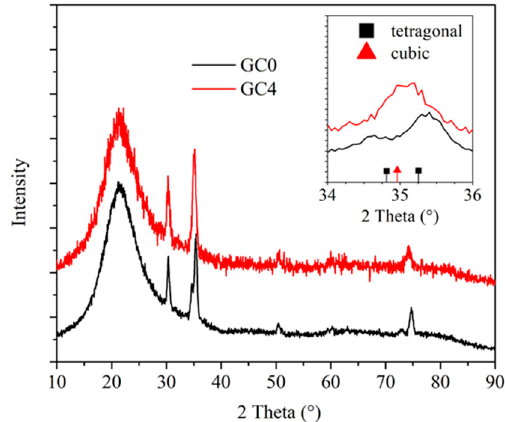
Figure 2. XRD comparison between undoped (GC0) and Yb-doped (GC4) silica-zirconia samples. The inset reports a selected region of the di ff raction pattern around 2 θ ≈ 35 ◦ , attesting to di ff erent crystal structures of the two samples: tetragonal-phase (di ff raction standard reference ICSD #85322) zirconia nanocrystals in undoped GC0 and cubic-phase (di ff raction standard reference PDF #49-1642) zirconia nanocrystals in Yb-doped GC4.